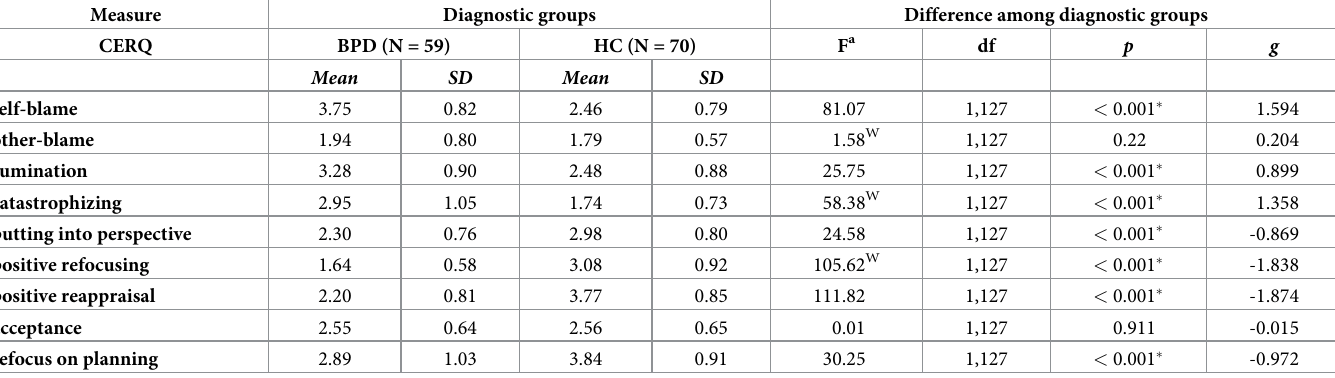
Table 5. Group comparisons of the BPD and HC groups on the subscale scores of the cognitive emotion regulation questionnaire, and effect sizes measured by Hedge’s g formula. Measure